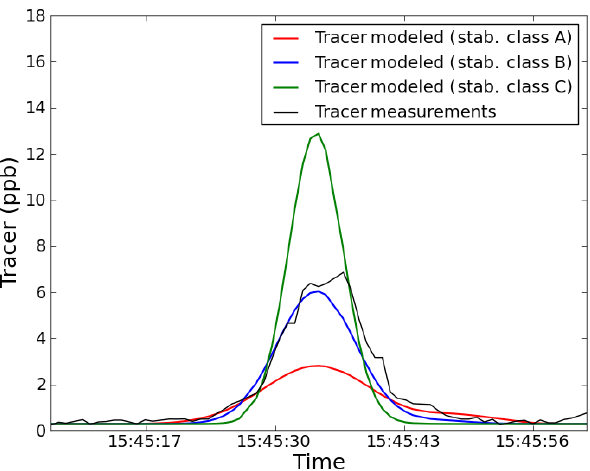
Figure 3. Example of the Briggs parameterisation selection with the acetylene data for peak 5 of configuration 2. The measured con- centrations are presented in black, and the modelled concentrations with different stability classes are shown in